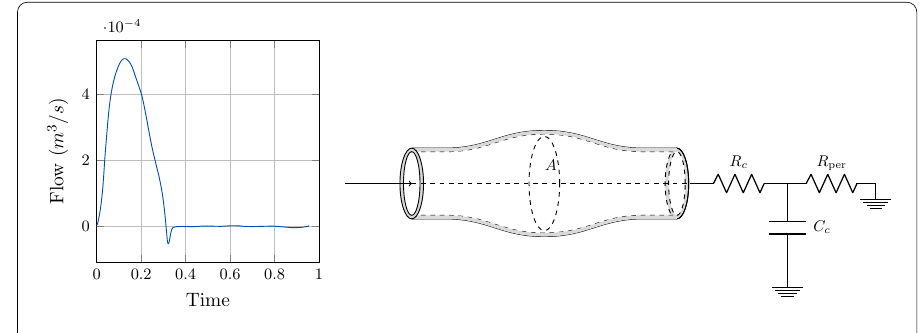
Fig. 4 Scheme of the uncoupledaorticmodel : single 1D vessel that represents the upper thoracic aorta and a three-element Windkessel model as boundary conditions to represent the remaining part of the circulation